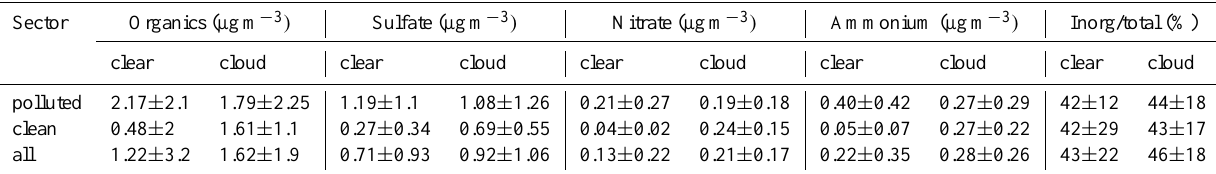
Table 4. Average mass concentrations and standard deviations of the chemical constituents measured by the AMS for the sectors with and without local pollutant sources, for the whole data set and for both clear and cloudy conditions. Data are from the total sampling line.